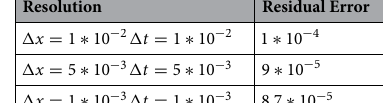
Table 1. Residual calculation for different resolution of (cid:31) t and (cid:31) x for M = 4.5 .